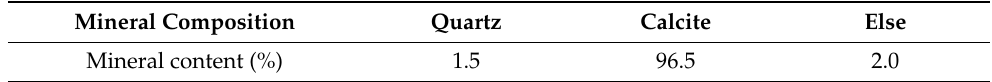
Table 1. XRD analyses of carbonate rocks [7].